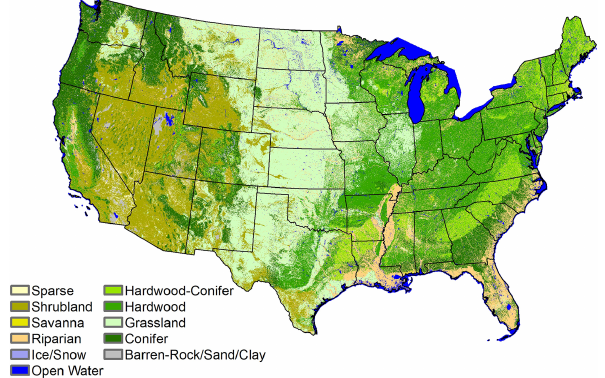
Figure A1. Vegetation type of pre-Euro-American settlement (Rollins,